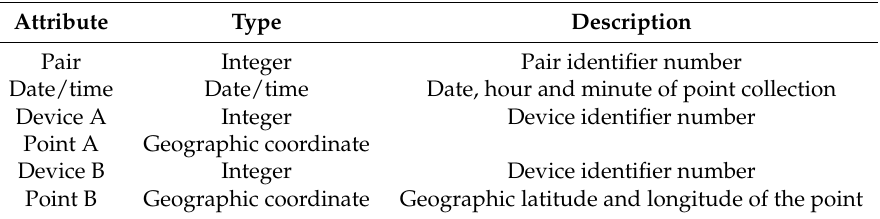
Table 7. Algorithm 1.2 output structure (detection of proximity pairs).